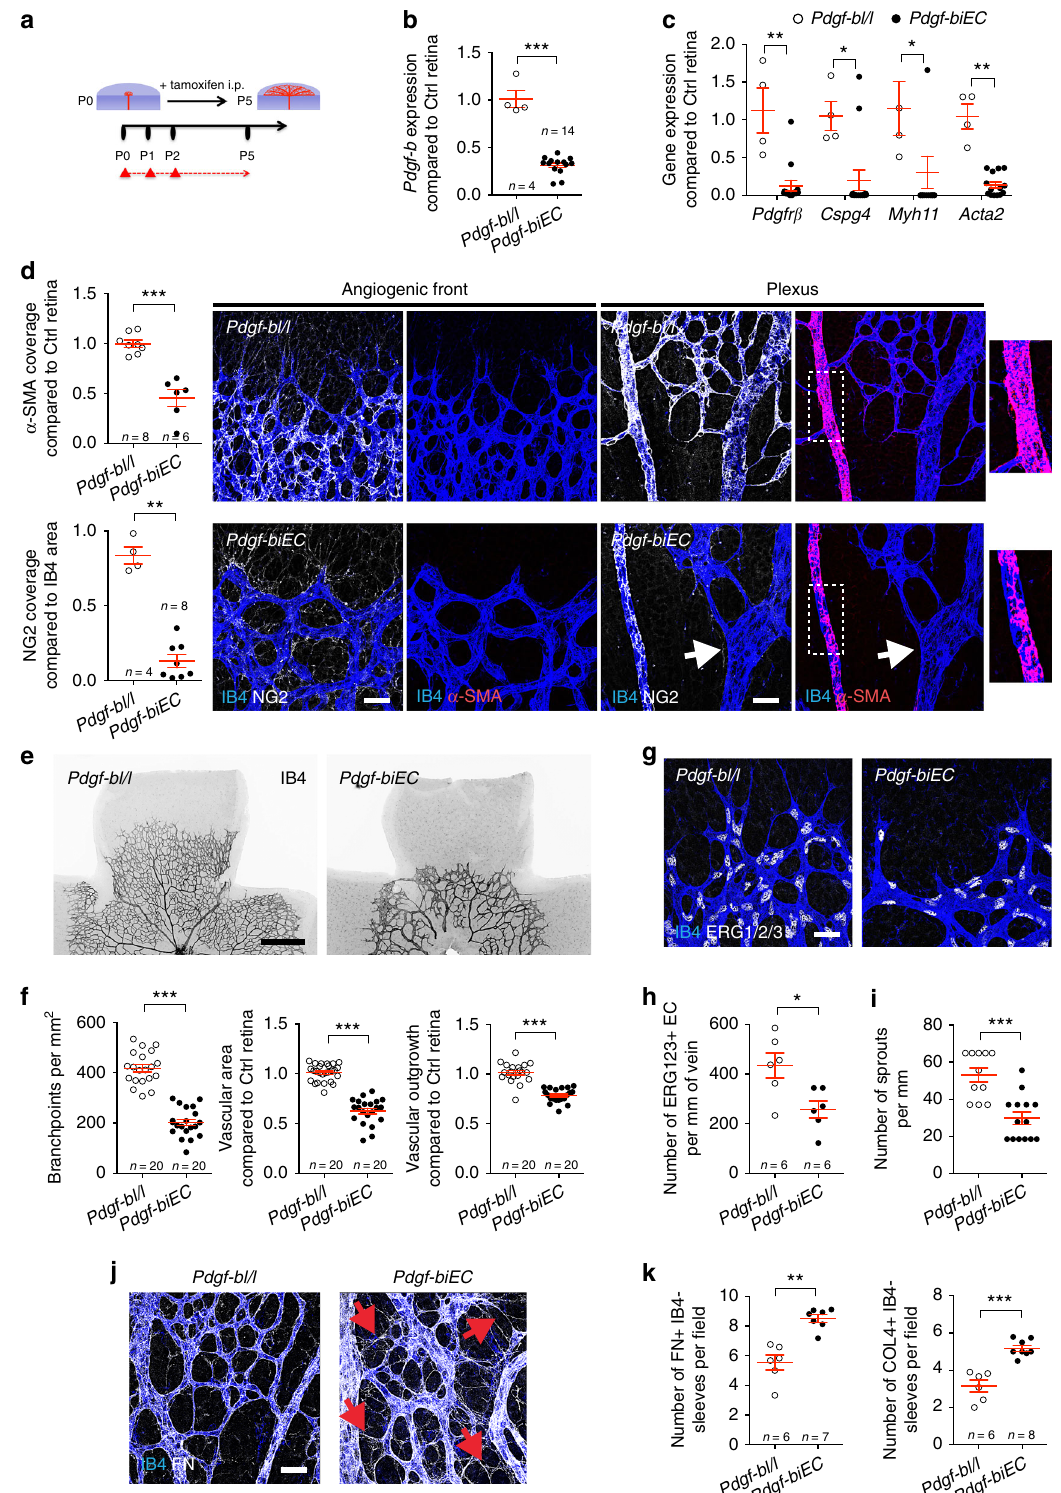
Endothelial Pdgf-b promotes NVT formation in ischemic retinopathy . To determine whether PDGF-B-dependent pericyte recruitment contributed to NVT formation in ischemic retino- pathy, we subjected Pdgf-biEC mice to OIR. Induction of Pdgf-b deletion was done after hyperoxia exposure during the neo- vascularization period (P12 – P17; Fig. 5a). As expected, Pdgf-bl/l control littermates and Pdgf-biEC mice displayed